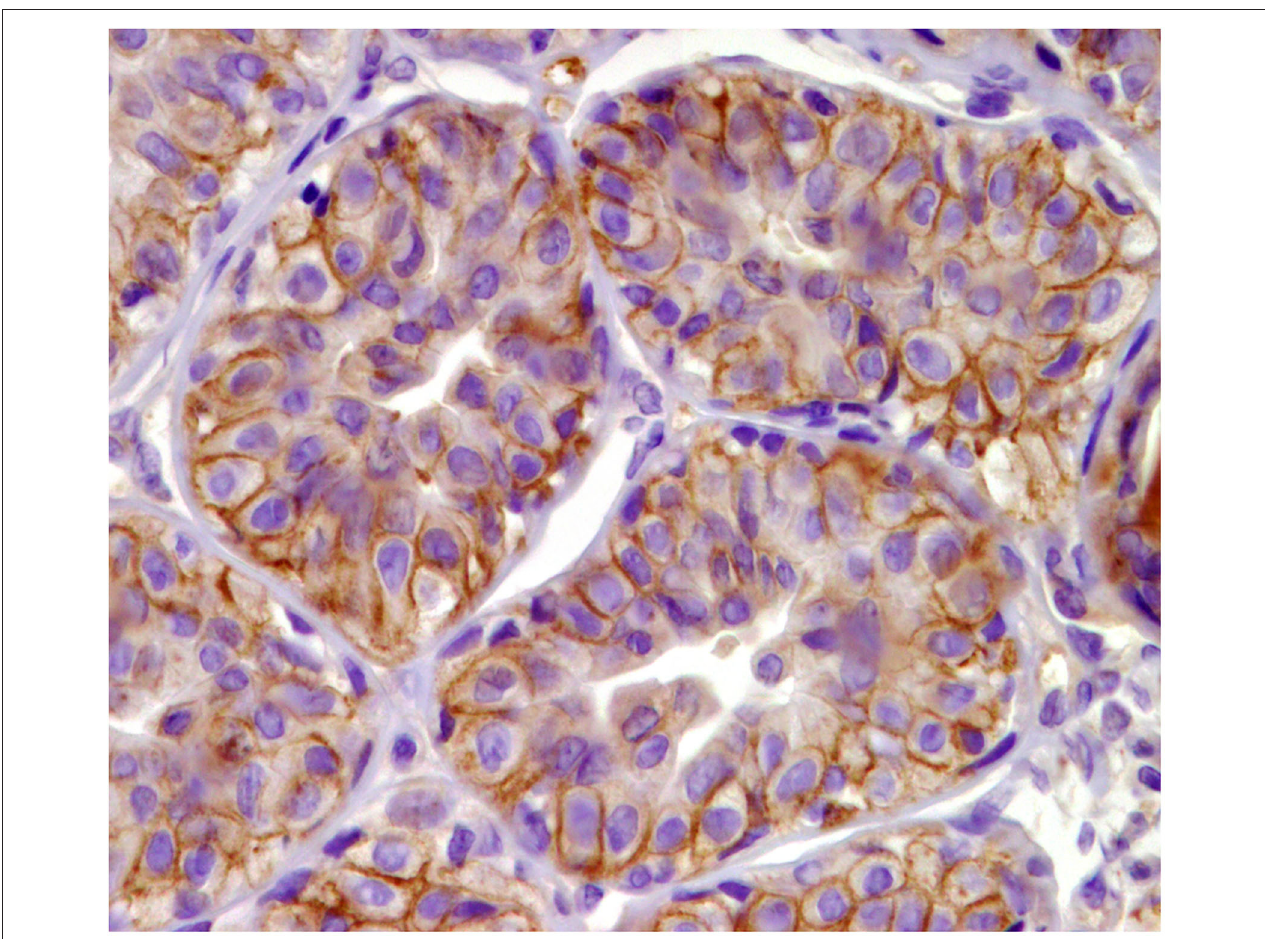
FIGURE 6 | Tubular carcinoma, mammary gland, dog. Immunohistochemical membranous staining of human epidermal growth factor receptor 2 (HER-2). Complete and incomplete membranous staining of neoplastic